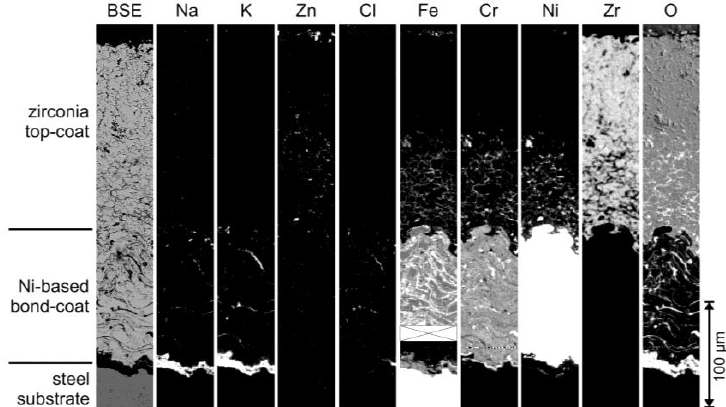
Figure 6. Back-scattered electron (BSE) image in combination with element mappings of sodium, potassium, zinc, chlorine, iron, chromium, nickel, zirconium, and oxygen of the multilayer coating from the lee-side of a cooled test probe (TP 2.1—450 °C for 23 days). The element mapping of Fe is separated into two parts with different scales in order to visualize distribution of different amounts within the coating: upper part—low amount (25–250 cts); lower part—high amount (400–1200 cts) of Fe.